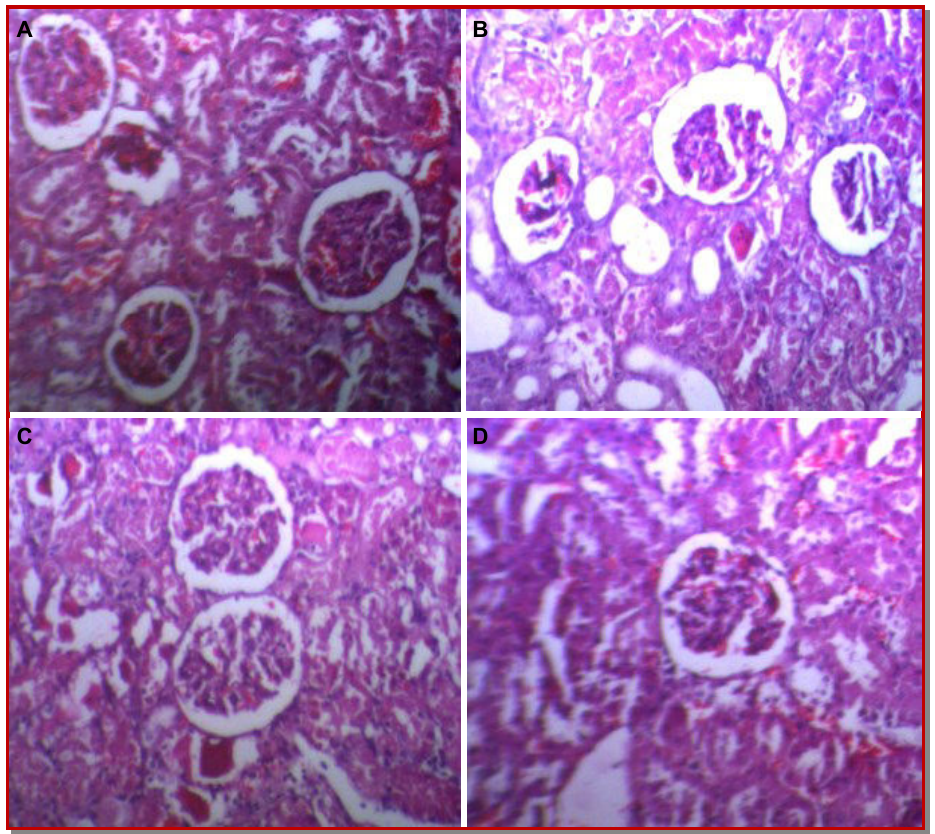
Figure 1: Effect of aqueous extract of leaves of Sechium edule on gentamicin-induced nephrotoxicity in rats A: Normal control; B: Treated with gentamicin (100 mg/kg, i.p.); C: Treated with Sechium edule (200 mg/kg) and gentamicin (100 mg/kg, i.p.); D: Treated with Sechium edule (100 mg/kg) and gentamicin (100 mg/kg,